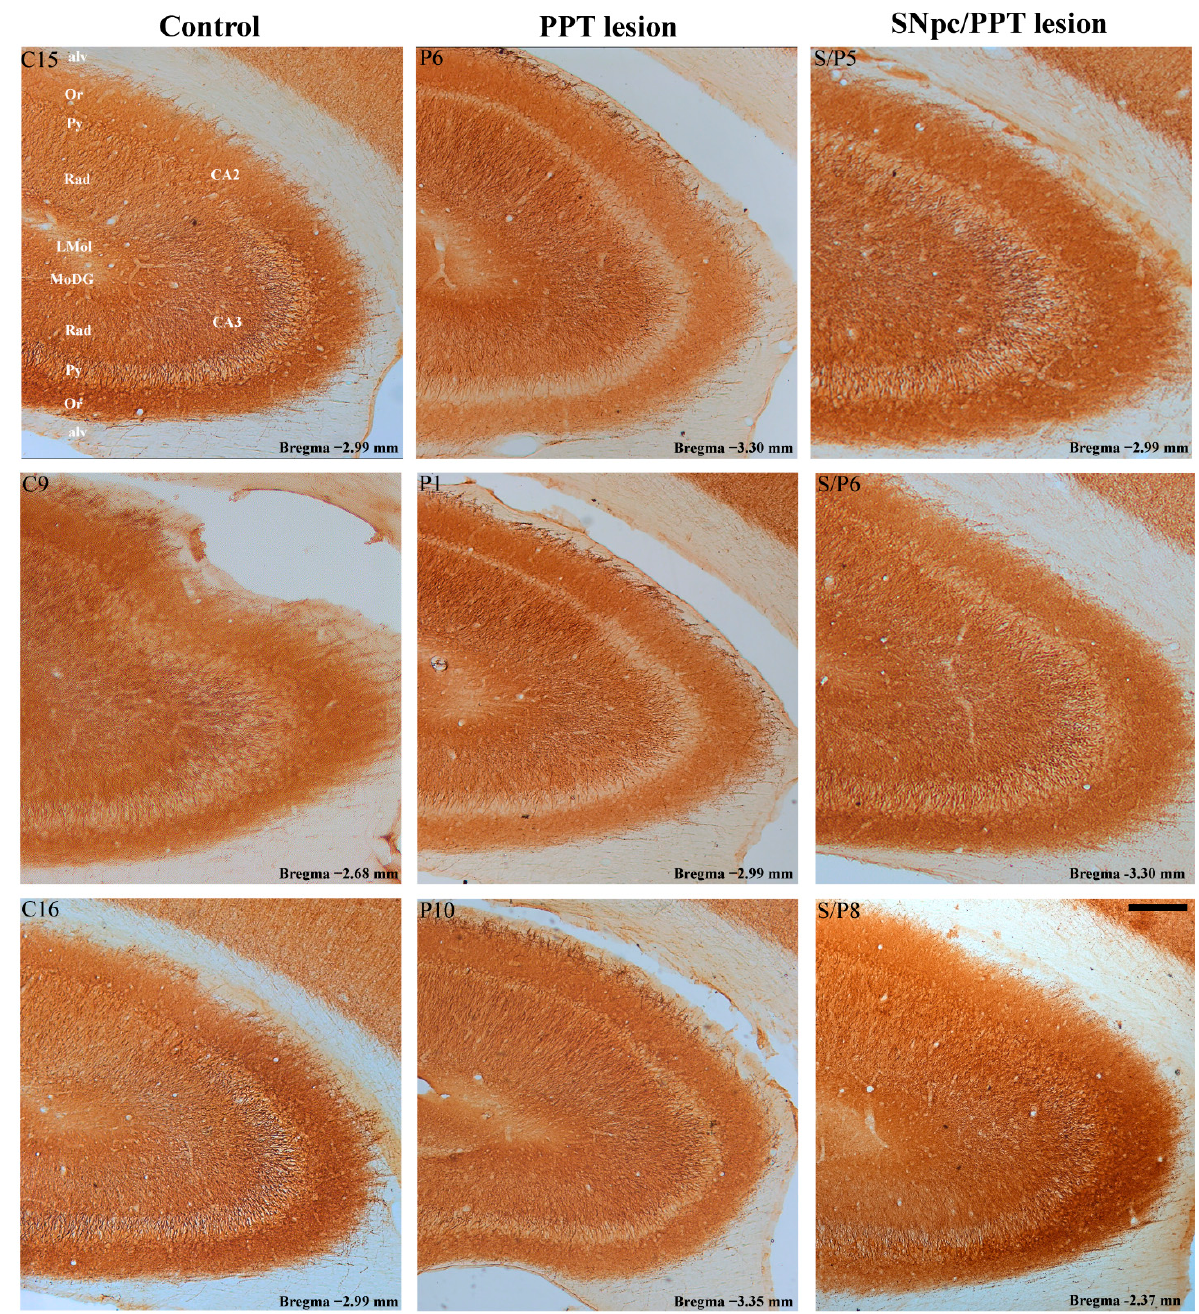
Figure 8. Alteration of MAP2 immunostaining within CA3 in the distinct rat models of PD neuropathology. MAP2 immunoreactivity within CA3 of the control rats (Control, C15, C9, C16), the rats with PD cholinopathy (PPT lesion, P6, P1, P10) and the hemiparkinsonian rats with PD cholinopathy (SNpc/PPT lesion, S/P5, S/P6, S/P8). alv—alveus of the hippocampus; Or—oriens layer of the hippocampus; Py—pyramidal cell layer of the hippocampus; Rad—radiatum layer of the hippocampus; LMol—lacunosum moleculare layer of the hippocampus; MoDG—molecular layer of the dentate gyrus; CA2—CA2 field of the hippocampus; CA3—CA3 field of the hippocampus. Scale bar is 200 µ m. MAP2 immunoreactivity was suppressed in the rats with PD cholinopathy, but it was enhanced in the hemiparkinsonian rats with PD cholinopathy within the pyramidal cell layer and stratum radiatum of hippocampal CA3 region vs. the control rats.